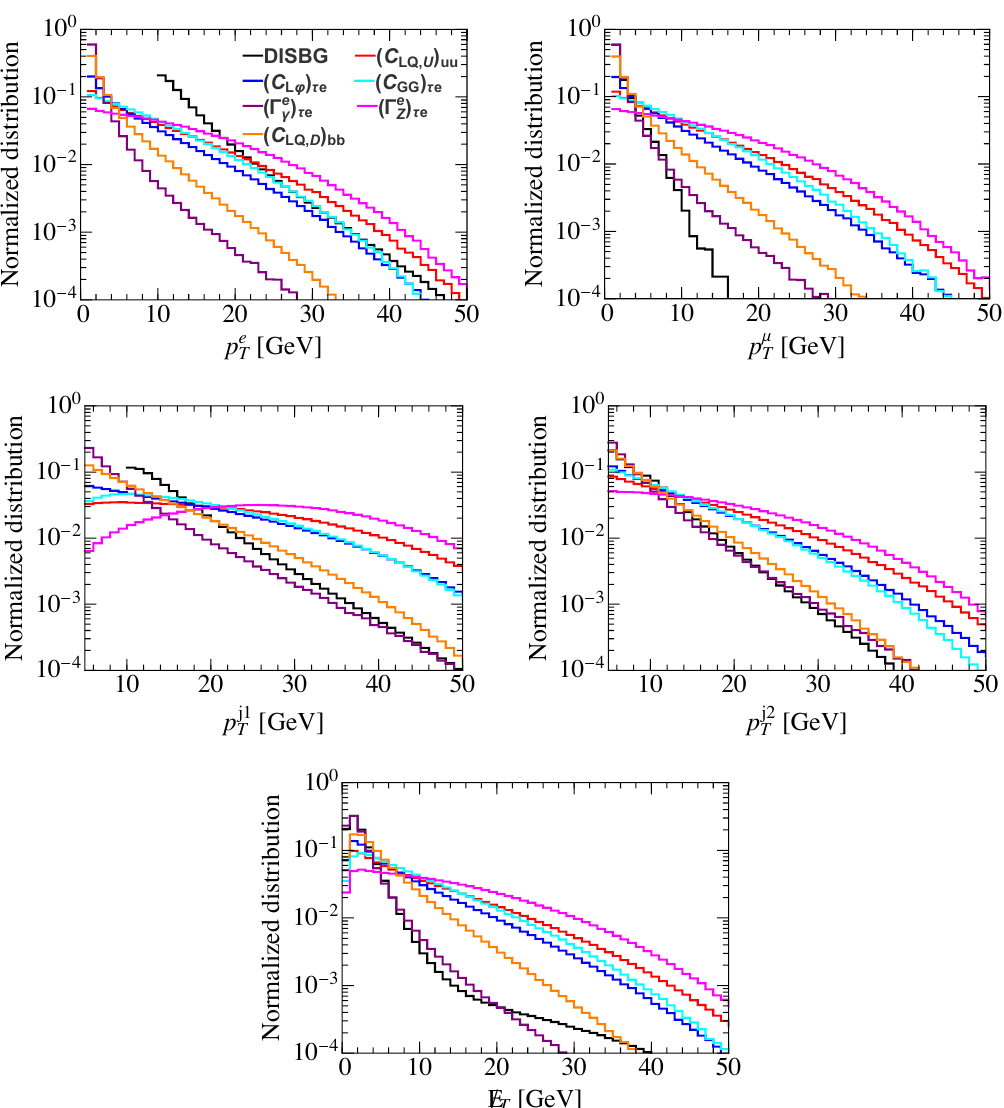
Figure 6 . Electron, muon, leading and subleading jet p T distributions and missing energy distribu- tion induced by SMEFT operators with left-handed τ leptons and by the SM background (DISBG) √ at the EIC, with E = 20 GeV and E = 250 GeV ( S = 141 e p